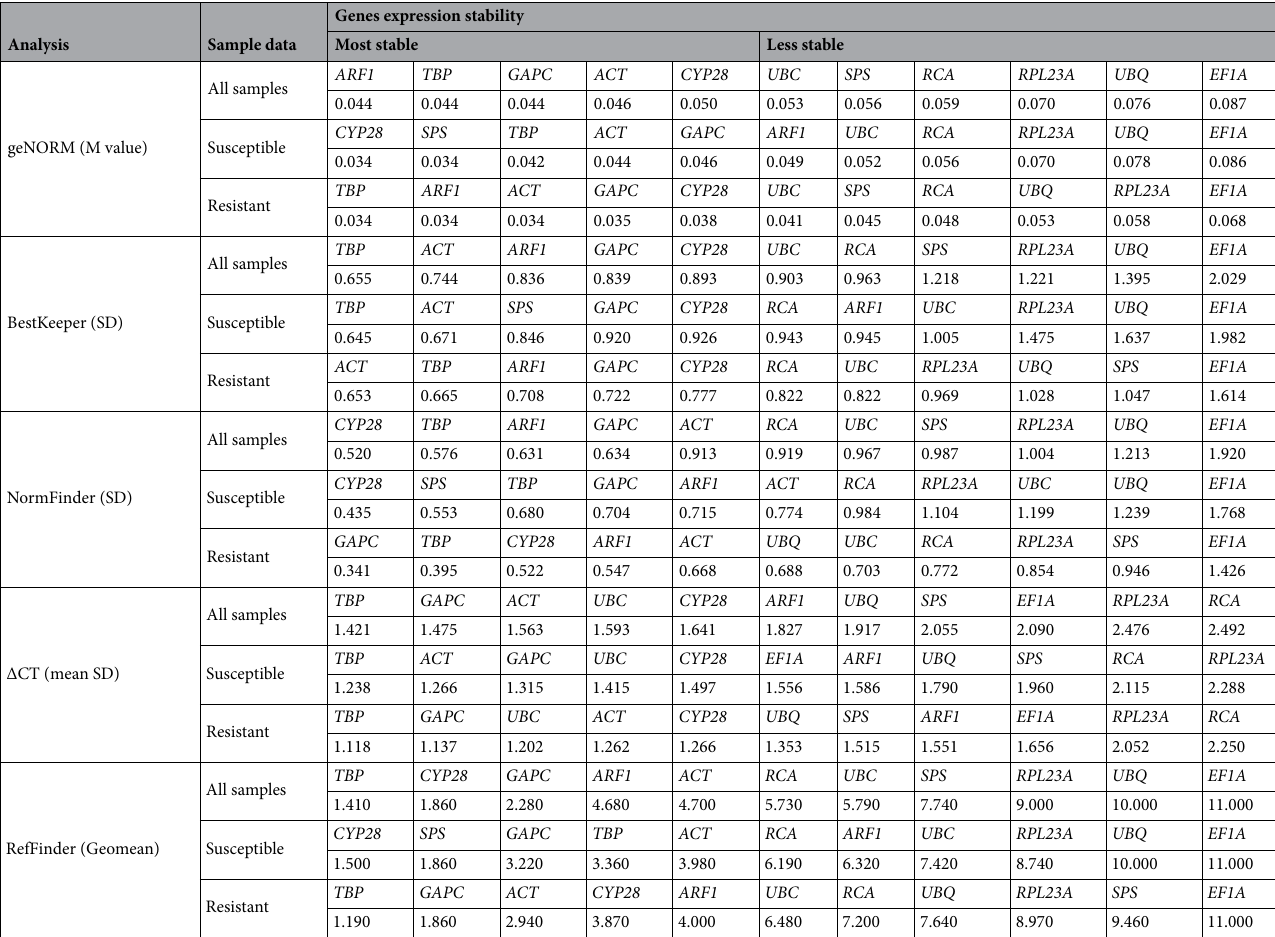
Table 3. Expression stability ranking of eleven candidate genes in Apera spica-venti plants resistant and susceptible to pyroxsulam. The input data consisting for geNorm, BestKeeper, NormFinder, ΔCt, and RefFinder calculations of were Cq values after efficiency